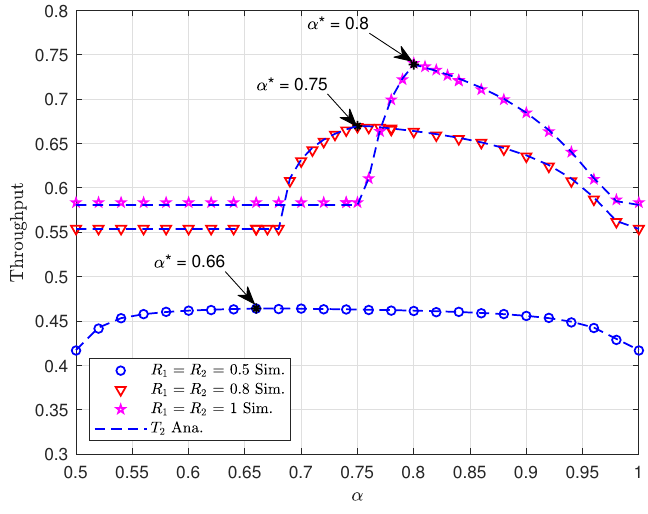
Figure 6. Throughput of user U 2 vs. α .